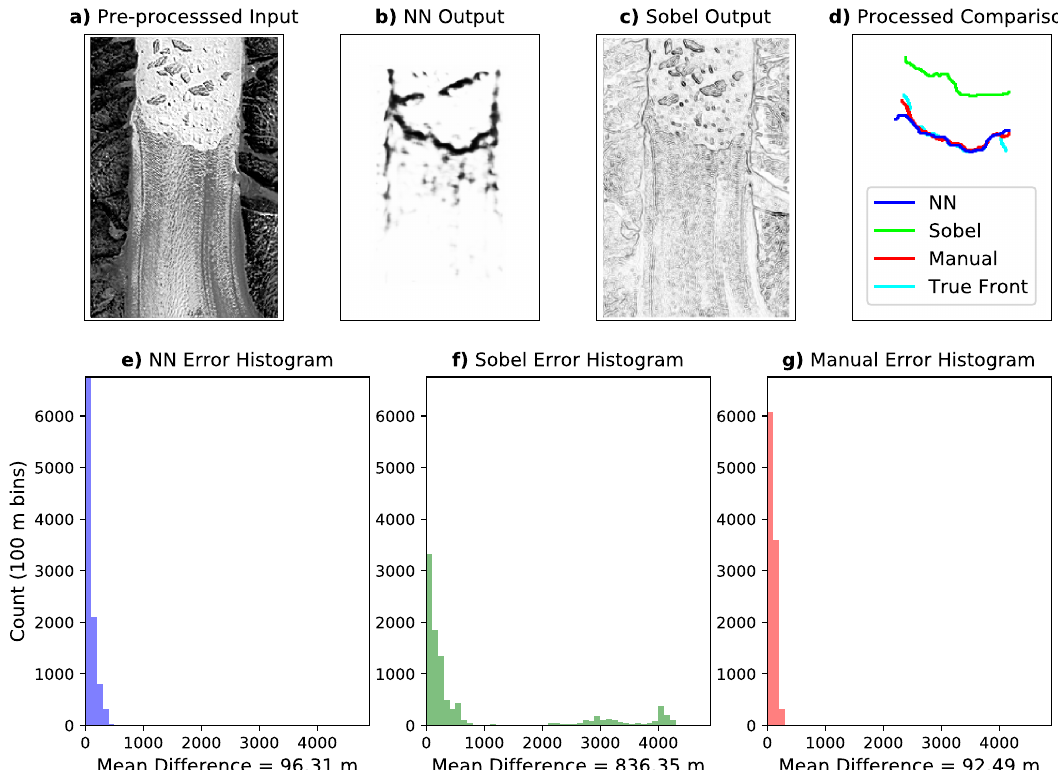
Figure 3. The output of the neural network shown for a sample test image of Helheim Glacier from Landsat 5. The pre-processed input image is shown in Panel ( a ). Panels ( b , c ) show the raw outputs of the neural network and the Sobel filter, respectively. Panel ( d ) depicts the corresponding extracted calving fronts compared to the true front, with the addition of the manually-determined front on the same resolution rasterized image used for the NN and Sobel filter. Note that the output of the NN shows remarkable agreement with the true front. Panels ( e – g ) show the distribution of differences between the generated and true fronts across all test images, with the corresponding mean differences with the true fronts for the NN, Sobel, and manual results, respectively. The NN difference of 96.3 m corresponds to 1.97 pixels. Considering only the 8 of 10 cases where the Sobel filter correctly identifies the calving front, the mean differences for the NN, Sobel, and manual techniques are 85.3 m (1.74 pixels), 193.0 m (3.94 pixels), and 89.1 m (1.82 pixels),